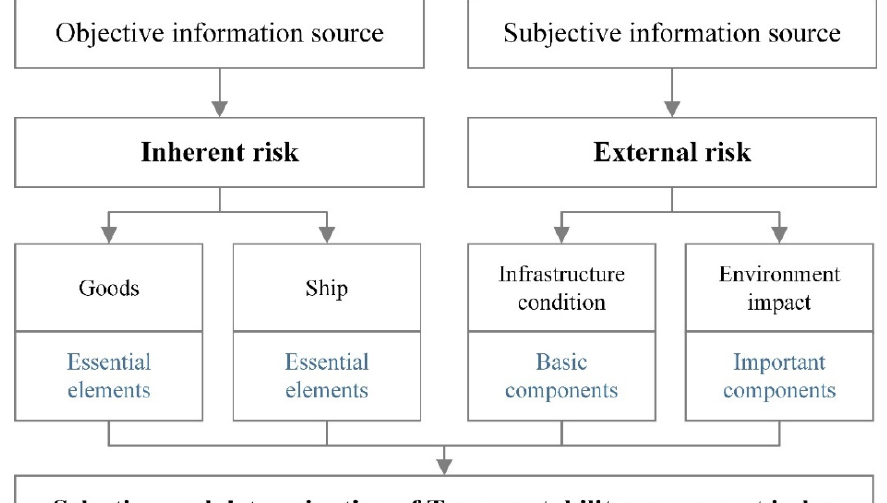
Figure 4. Brief stage process of transportability assessment framework.